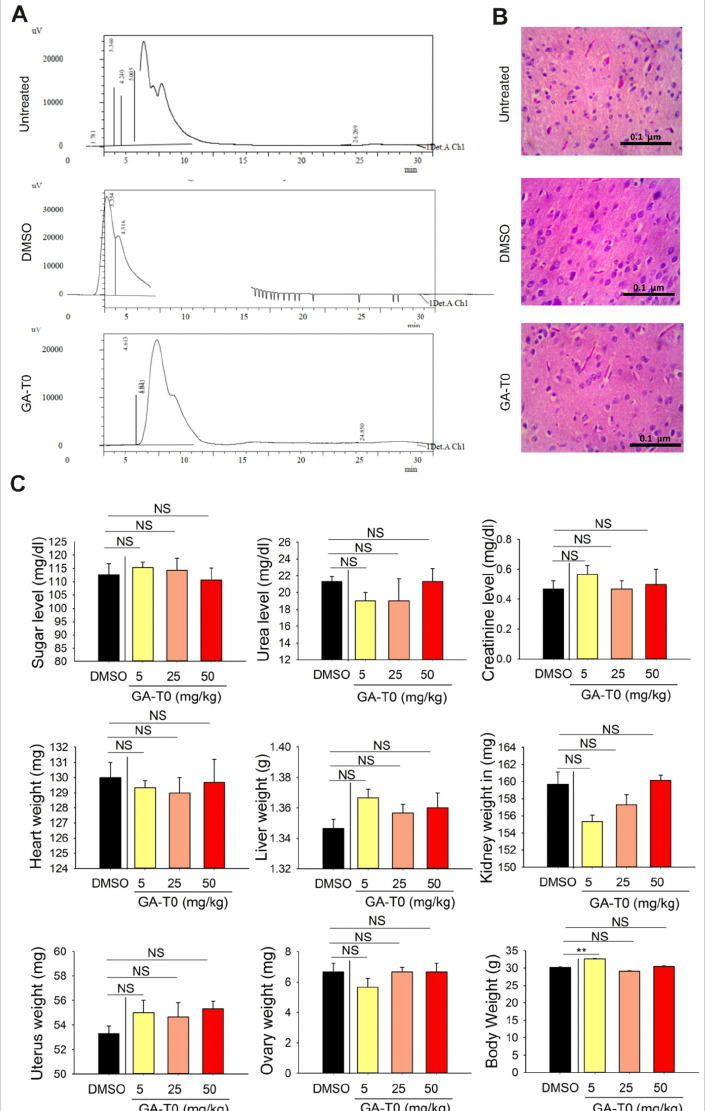
Figure 5. Ability of GA-T0 to cross the BBB in an in vivo model. ( A ) HPLC analysis showing the retention time in the control, DMSO, and GA-T0-treated Mus musculus . ( B ) Histopathology of the brain tissues from the control, DMSO, and GA- T0-treated wild mice. Photomicrographs of the cerebral cortex of the mice showing a normal architecture of the pyramidal neurons (PYC) in untreated and treated animals. ( C ) Changes in body weight, organ weight, and biochemical indicators, such as the sugar, creatinine, and urea (mg/dL) level, in wild mice upon GA-T0 treatment at varying concentrations, namely, 5, 25, and 50 mg/kg animal weight. Non-significant data are denoted by NS and significant data by asterisks; biological and technical repeats, n = 6, **, p <